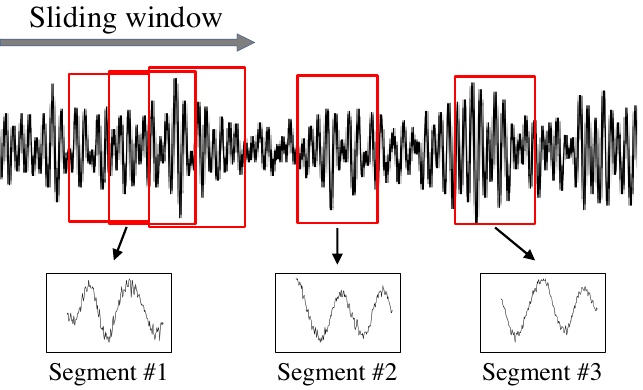
Figure 2. Illustration of the segmentation operation using sliding windows (overlapping (OL) for Segment #1 and Non-OL for Segments # 2 and 3) for a sample TS